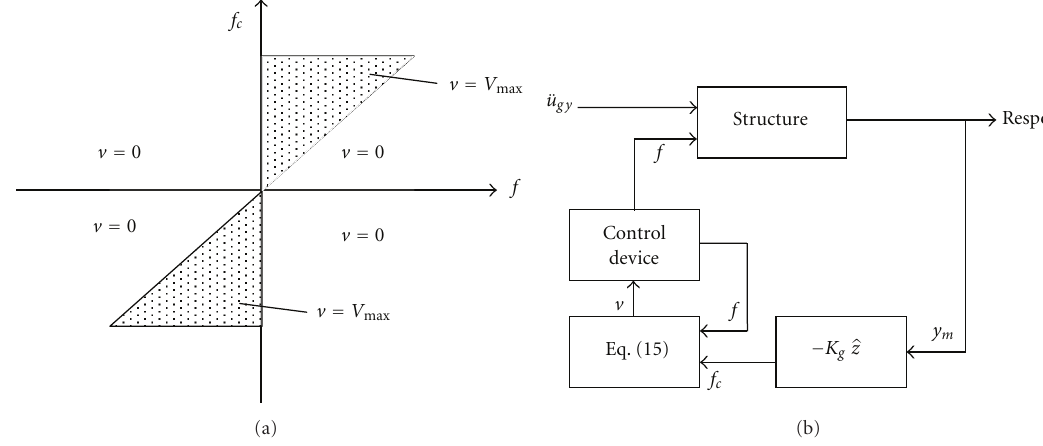
Figure 3: Graphical representation of clipped-optimal control algorithm [15] and semiactive control